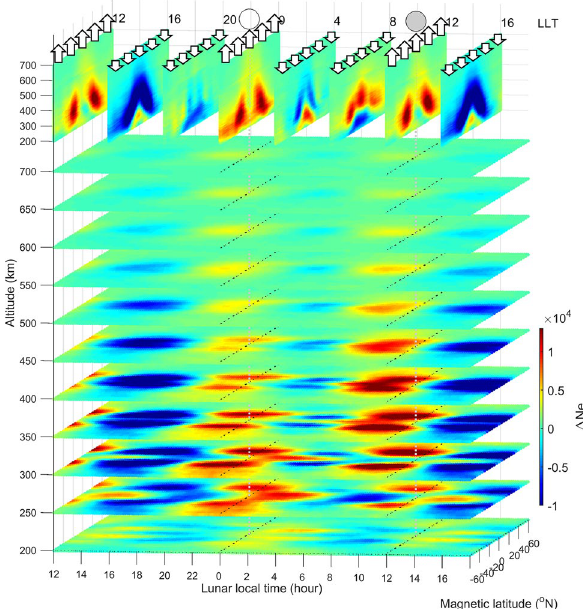
Figure 4. Composite 3D electron density structure observed by the F3/C and F7/C2 at various lunar local time during 2006–2020. Longitudinal slices every 3 LLT hours are shown at the top. Open arrows stand for lunar gravitational forces. The gray circle denotes the Moon position, while the white circle is the antipodal